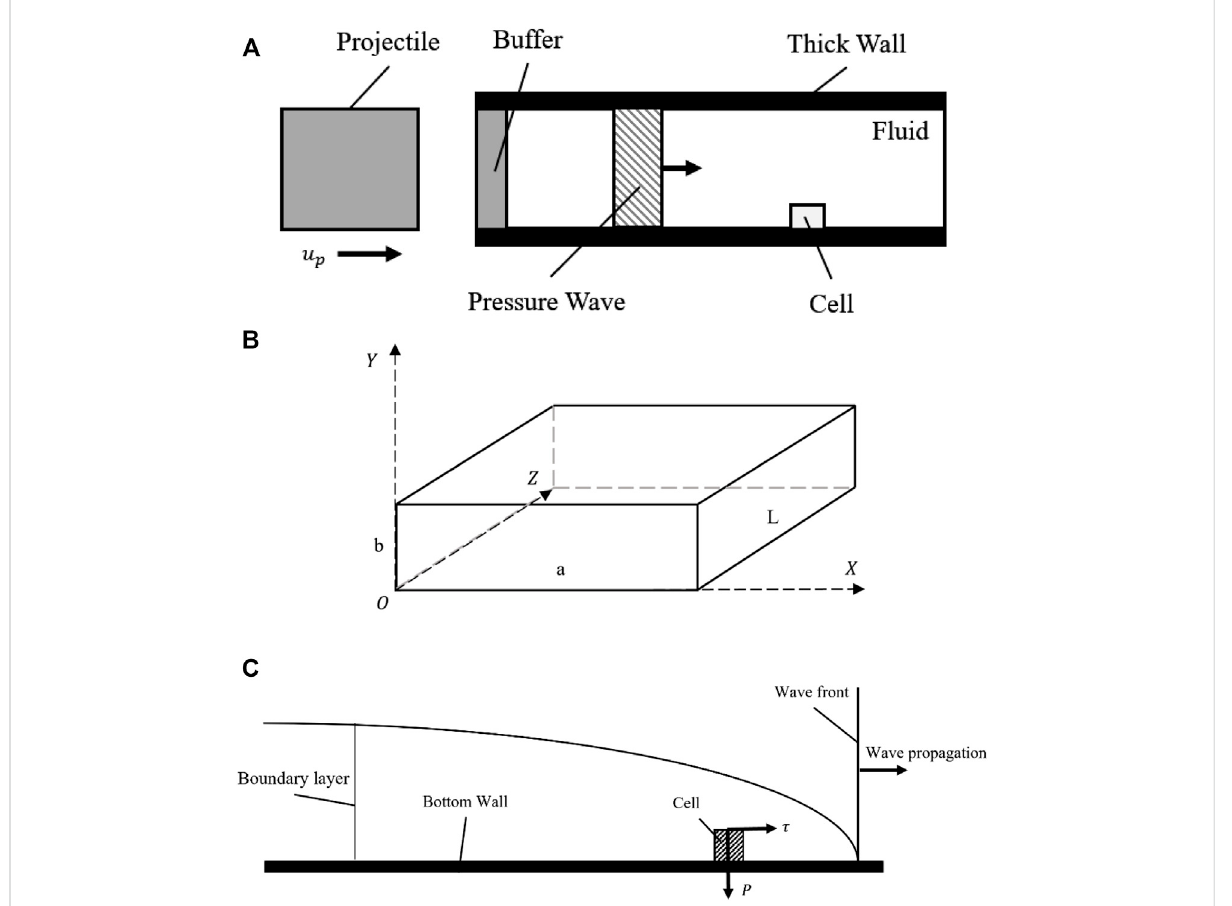
FIGURE 1 Aschematicdiagramshowingthebasicsoftheproposedmodel. (A) Theschematicdiagramofthegeometryofthemodel; (B) Thesketchofthe rectangular channel; (C) The stress analysis of cells during wave